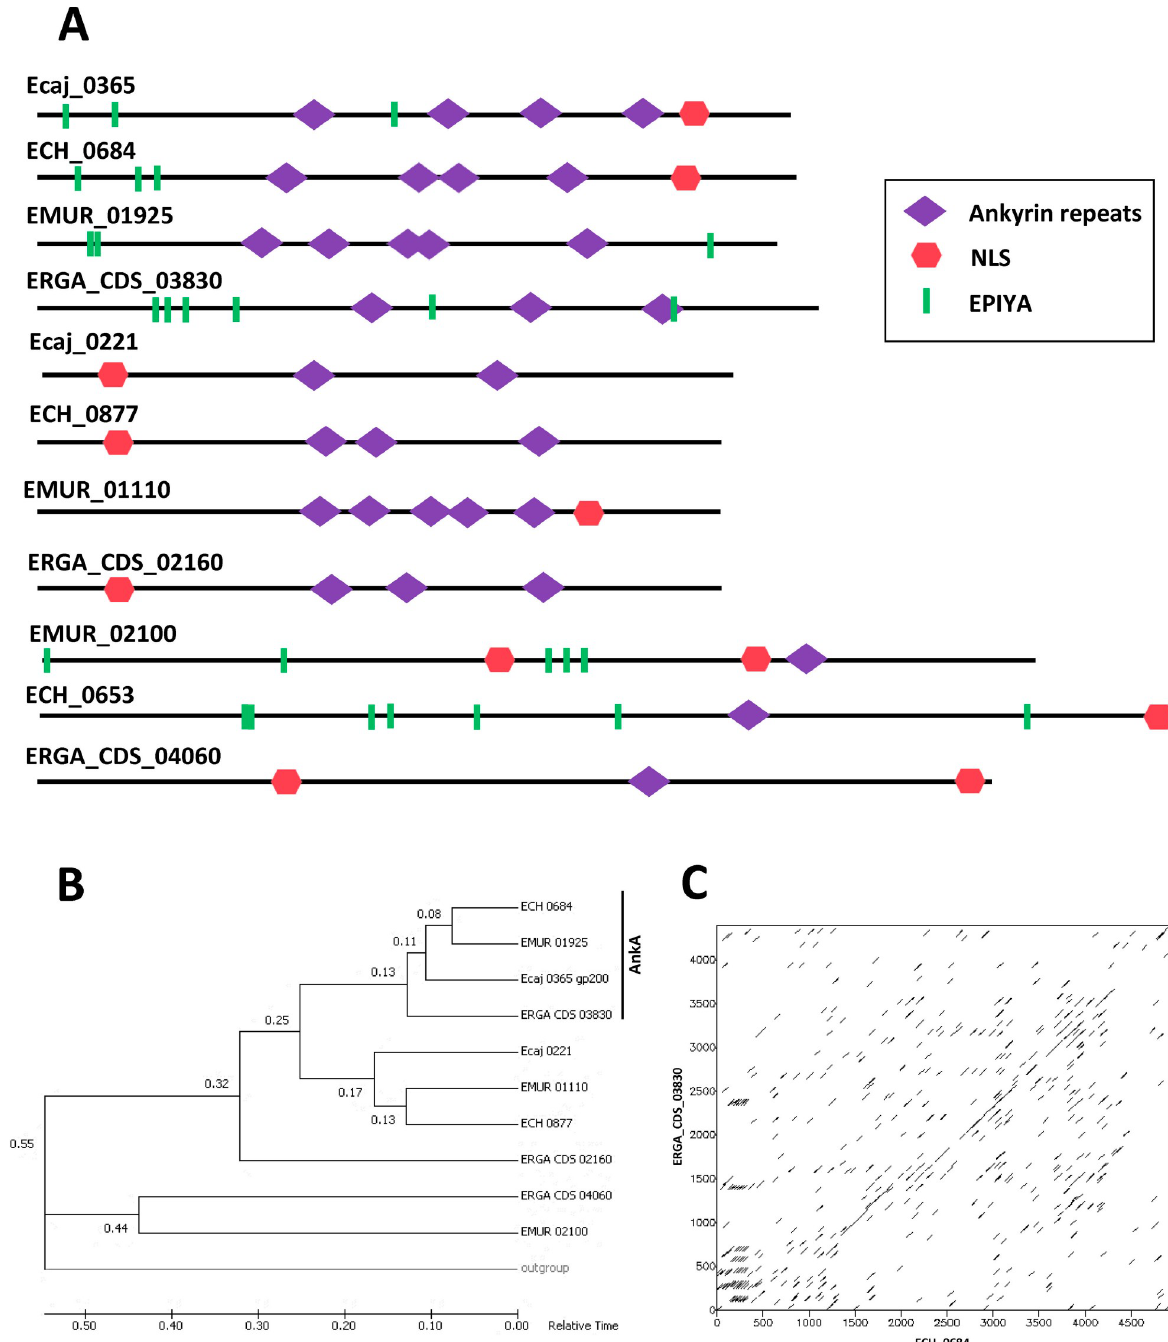
Fig 9. Ankyrin-containing predicted type IV effectors show diverse architectures and inter- and intragenic rearrangements in Ehrlichia spp. A. Each protein in Ehrlichia spp. pT4E whose architecture includes an ankyrin domain is represented. B . Relative time phylogenetic tree build from 11 nucleotide sequences of Ankyrin-containing predicted type IV effectors (pT4Es). ECH_0653 was used as outgroup. The numbers in front of each node represent the relative theoretical time from the putative common ancestor of two branches. Evolutionary analyses were conducted in MEGA7 [34]. C . Dot plot of regions of similarities between ECH-0684 (x-axis) and ERGA_CDS_03830 (y-axis). This graph was constructed with the dotmatcher software included in the EMBOSS package, where all positions from the first input sequence are compared with all positions from the second input sequence using a specified substitution matrix and using a window size of 50 and a threshold of 50. The two sequences are the axes of the rectangular dotplot. Wherever there is "similarity" between a position from each sequence a dot is plotted.